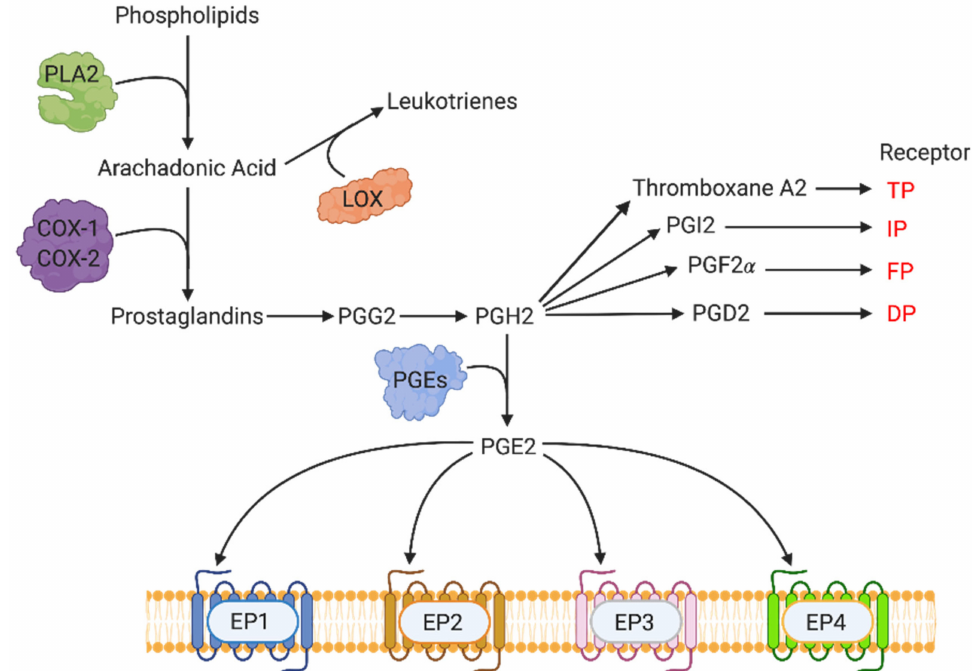
Figure 4. Pathway of prostanoid synthesis and their respective receptors. Phospholipase A2 (PLA2) facilitates arachidonic acid production by acting on membrane phospholipids. Arachidonic acid is converted to many different prostanoids (PGE2, Thromboxane A2, PGI2, PGF2 α and PGD2) via the COX-1 and COX-2 enzymes. These prostaglandins then mediate their functions through respective receptors. Figure adapted from Majumder et al., (2018)